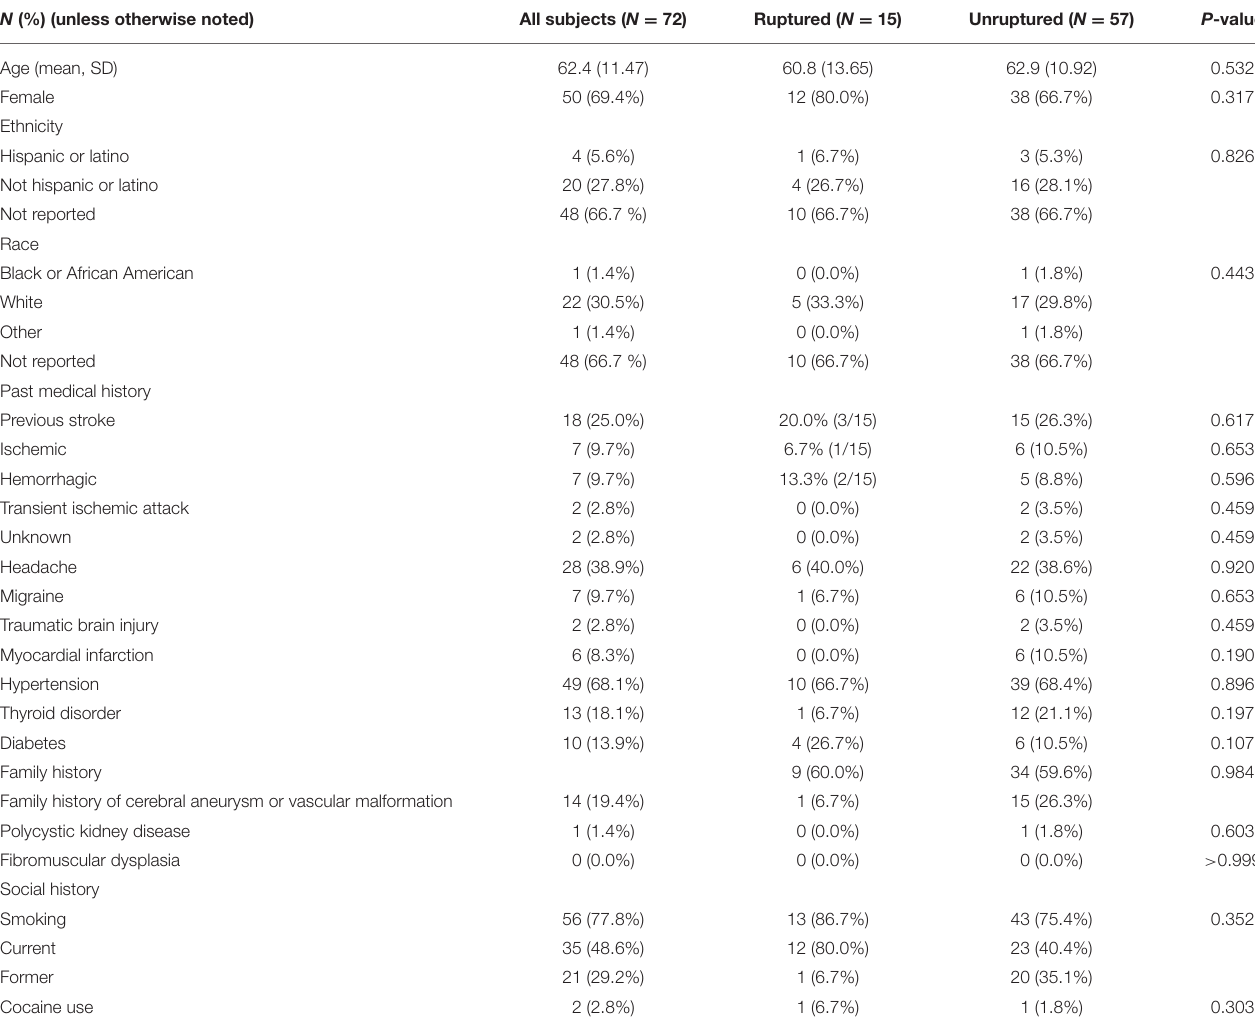
TABLE 1 | Demographics and past medical